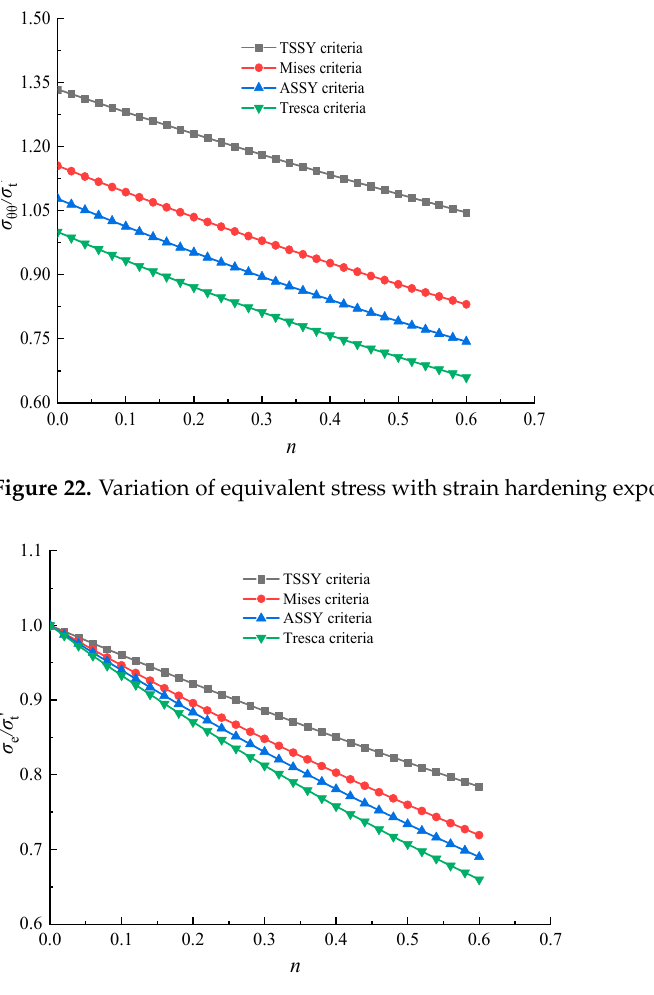
Figure 23. Variation of hoop stress with strain hardening exponent n